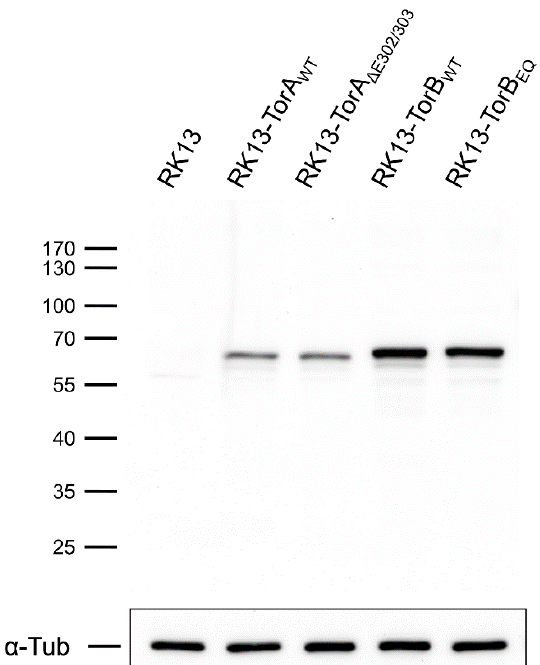
Figure 3. Expression of GFP-tagged Torsins in RK13 cells. Lysates of transfected cells were harvested, and proteins were separated in SDS 10%-polyacrylamide gels. Blots were probed with a GFP-specific rabbit antiserum and a monoclonal antibody against α -tubulin as loading control. Molecular masses of marker proteins (in kDa) are indicated on the left.